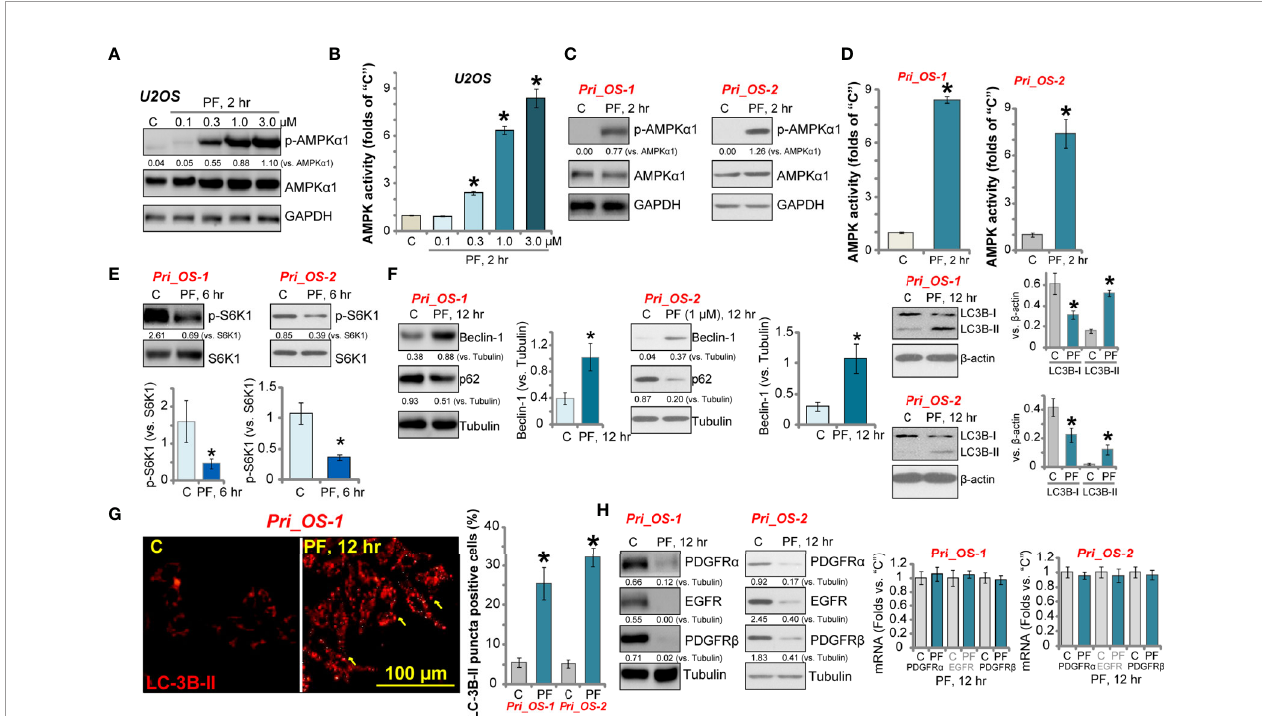
FIGURE 3 | PF-06409577 activates AMPK signaling cascade in human OS cells. U2OS cells (A, B) or the primary human OS cells ( “ Pri_OS-1 ” and “ Pri_OS-2 ” , C – H ) were treated with applied concentration of PF-06409577 for indicated time; expression of listed proteins in total cell lysates was tested by Western blotting assay (A , C , E , F , H) ; relative AMPK activity was also tested (B, D) . LC3B-RFP (red fl uorescence protein) puncta formation was shown, LC3B-RFP-puncta positive cell ratio was quanti fi ed (from 500 cells in each condition, G ). Expression of PDGFR a / b and EGFR mRNA was tested by qPCR assays (H) . Blot data were quanti fi ed and normalized to each loading control. For each assay, n = 5 ( fi ve replicate welsl/dishes) (B, D) . Data were presented as mean ± standard deviation (SD) (B, D) . * p < 0.05 vs. “ C ” cells (B, D) . Experiments were repeated three times, and each time similar results were obtained. Scale bar = 100 m m (G)